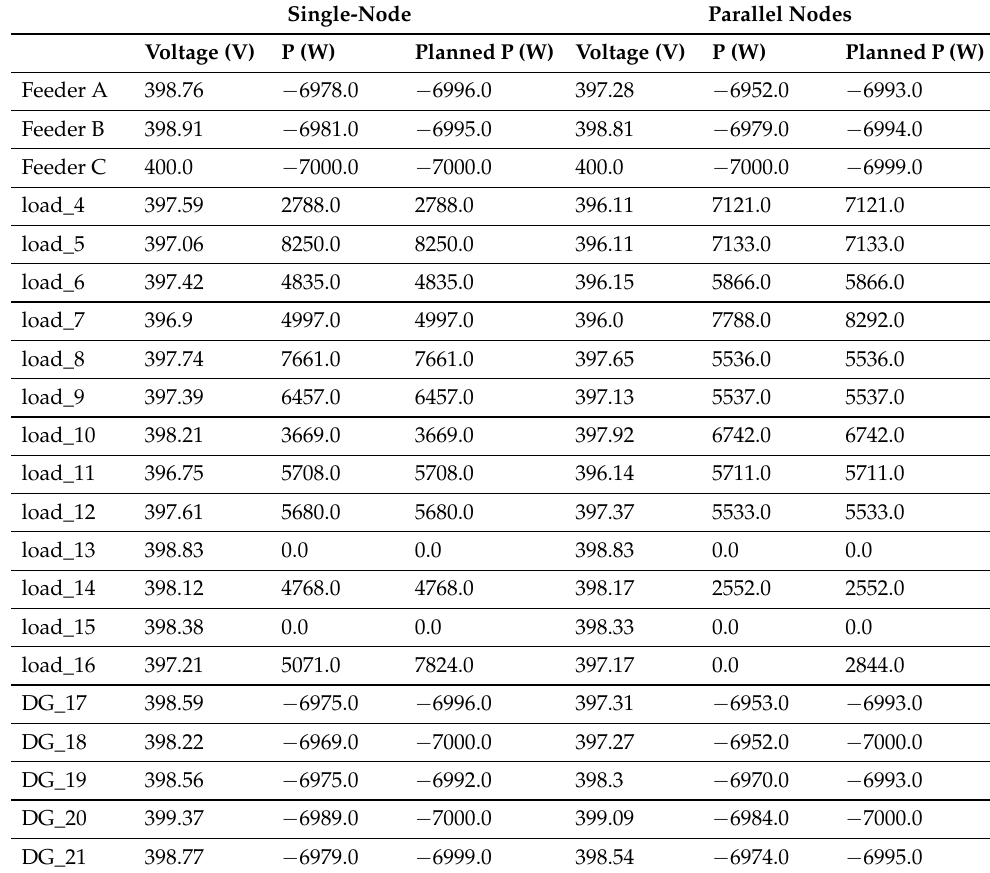
Table A2. One timestep of the simulation of the IEEE16 meshed grid with exernal grid connection. Comparison of the single-node and parallel nodes planners. Columns voltage (V) and p (W) cor- respond to the nodal voltage and power obtained by the executor; planned p (W) is the solution derived by the corresponding